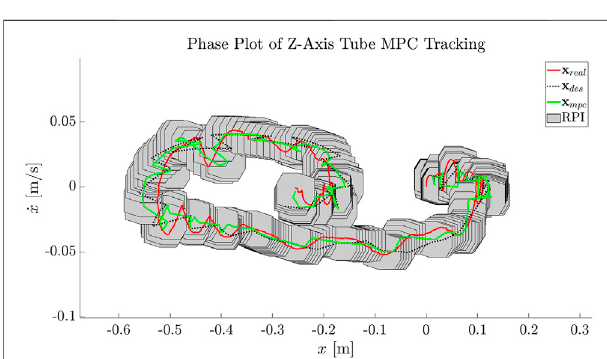
FIGURE 12 | An example of the robust tube MPC maintaining the real x (red) within an invariant set (gray polytope) centered on the nominally planned MPC solution (green). Here, the RPI is shown for the fi rst timestep of each receding horizon MPC solution.